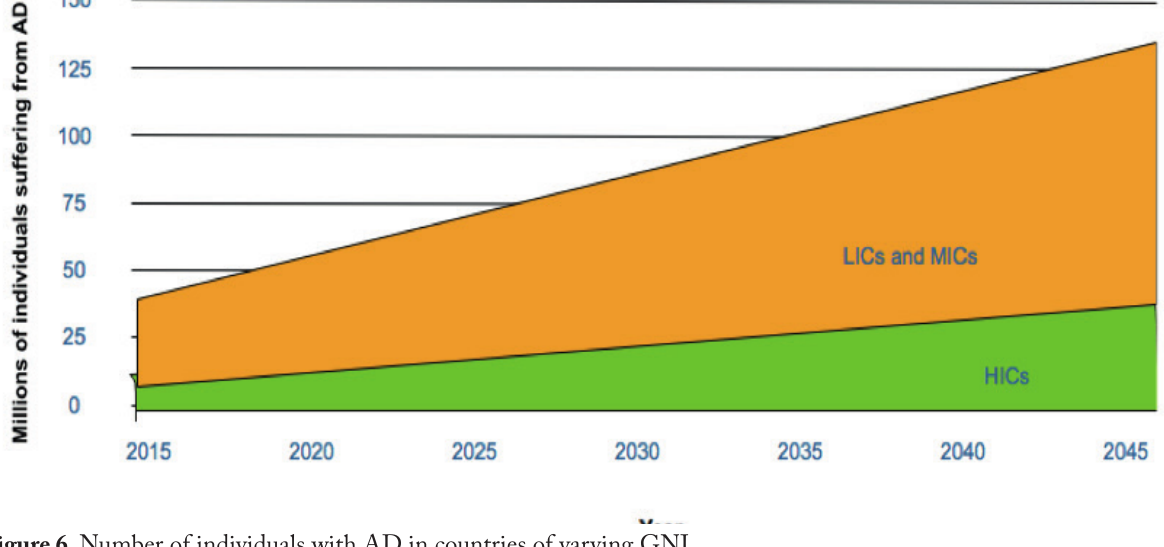
Table 8. Numbers of individuals with AD (millions) according to the 2015 World Bank income classification. World Bank Income Group